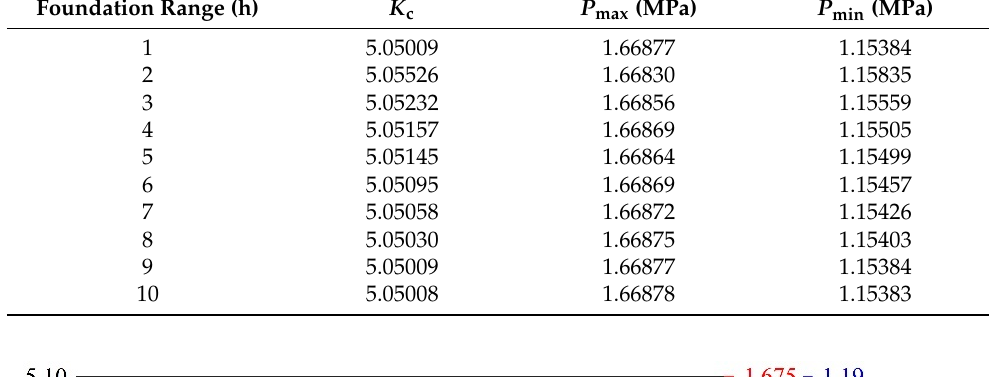
Table 3. Calculation results.